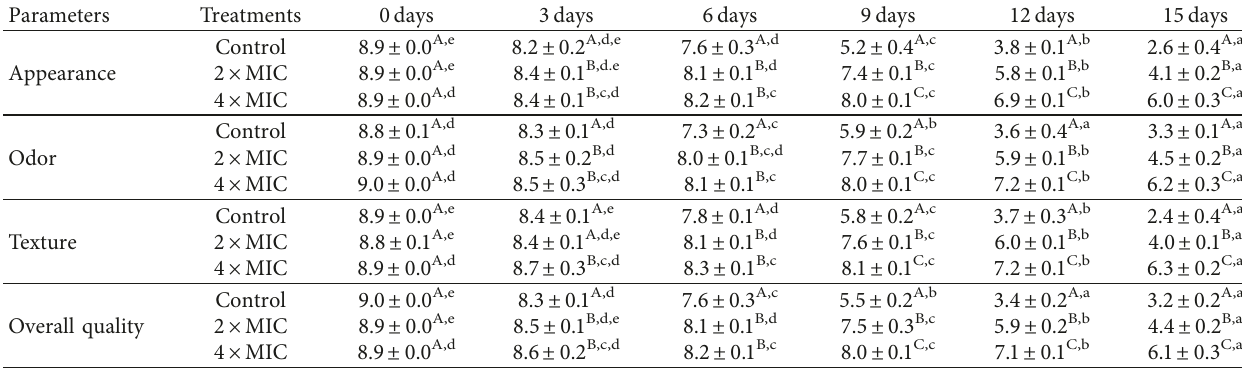
Table 3: Changes in sensory scores of chilled mackerel fillets packed with the films incorporated without/with 2 × MIC and 4 × MIC bifidocin